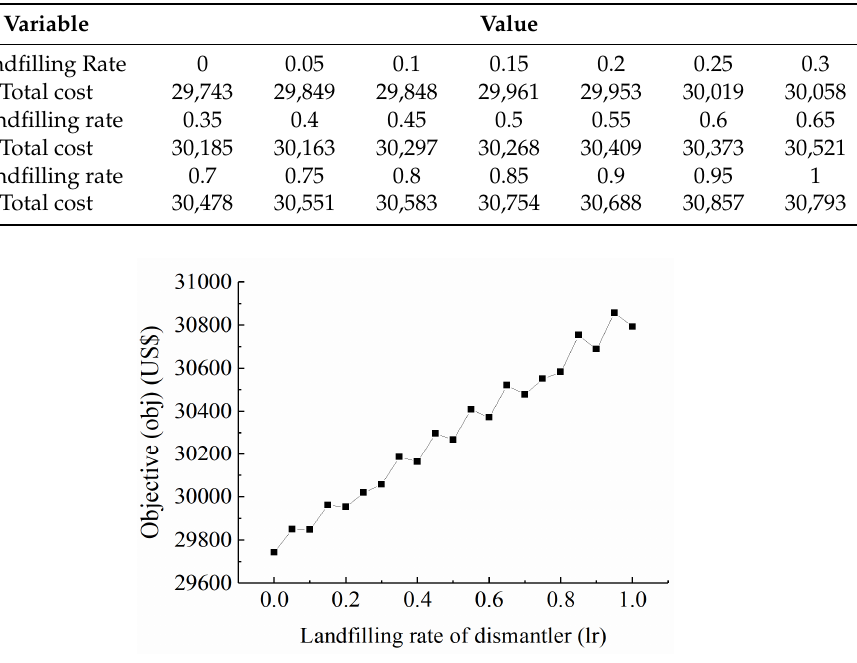
Figure 10. The relationship between landfilling rate and total cost.